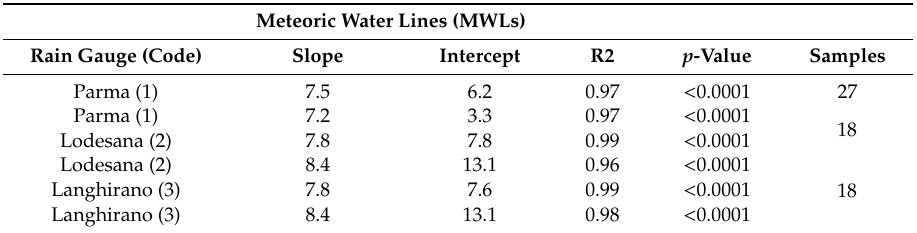
Table 2. Unweighted (MWLs) and Weighted Meteoric Water lines (WMWLs) for rain gauges considered in this study obtained from unweighted and weighted isotopic composition (in bold), respectively. The number of samples used for interpolations (ordinary least squares regression-OLSR) are also reported along with statistical parameters (R 2 and p -value).